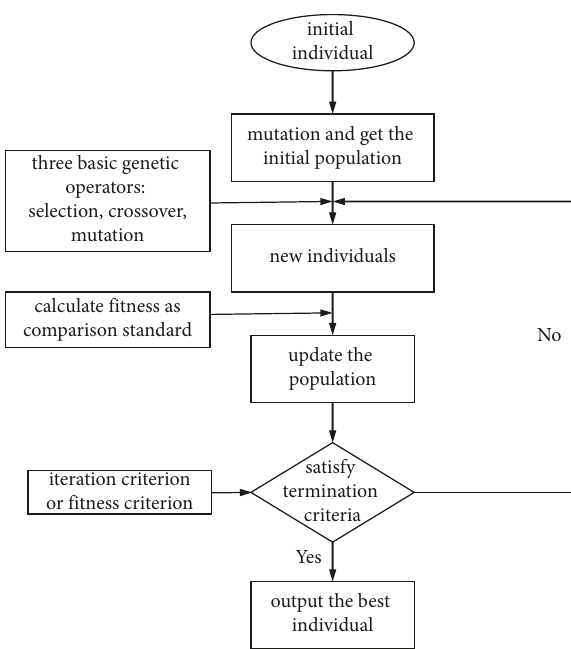
Figure 4: Genetic algorithm flowchart.